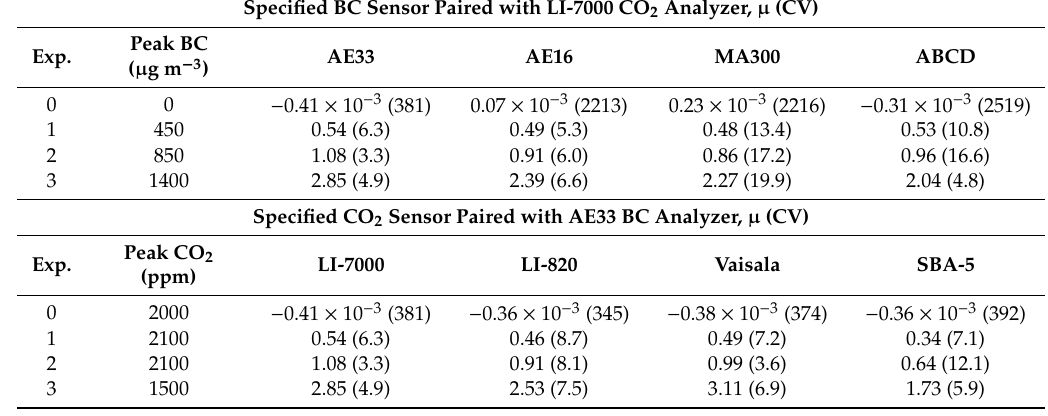
Table 2. Emission factor means ( µ , g kg − 1 ) and coe ffi cients of variation (CV, %) based on the combination of measurements from the specified BC and CO 2